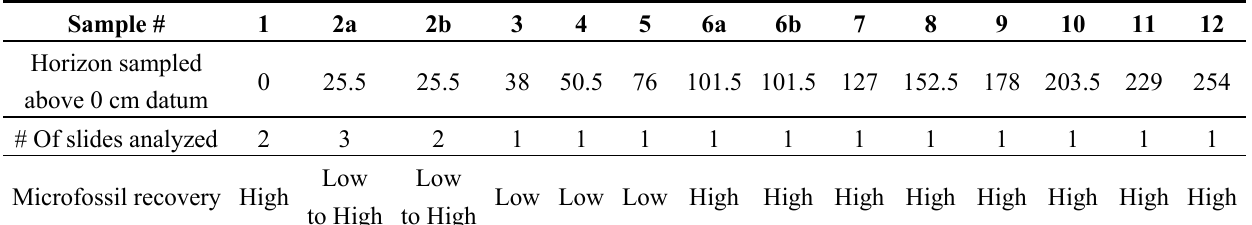
Table 1. Samples Studied. List of sediment sample numbers, horizon in which samples were collected, number of slides analyzed for each sample and degree of microfossil recovery. High, more than 300 dinocysts per slide. Low, fewer than seven dinocysts per